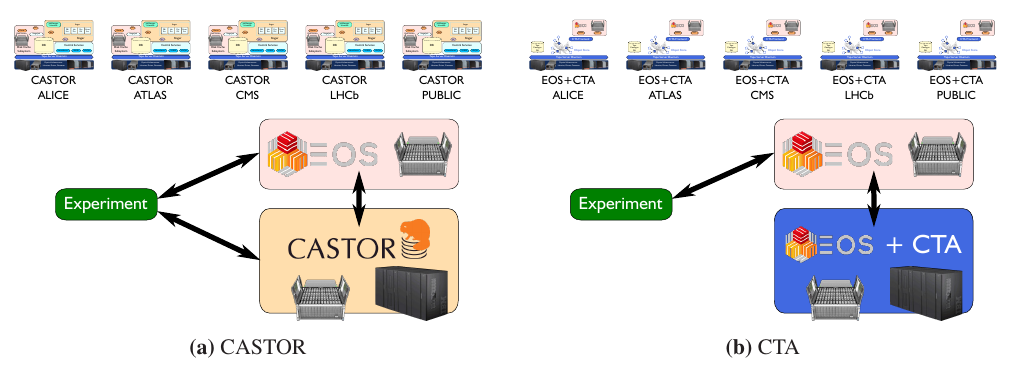
Figure 5. Deployment strategies for CASTOR and